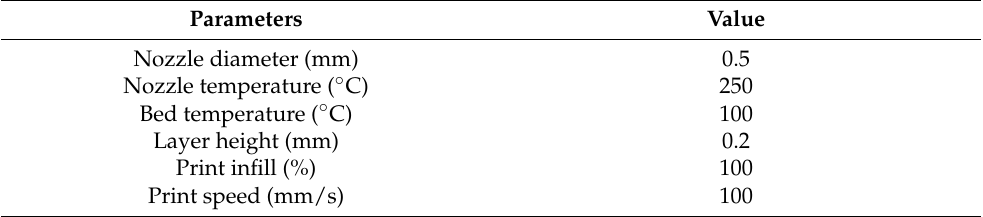
Table 1. Parameters used for the FFF 3D printing of pure HIPS and HIPS-0.5 filaments.